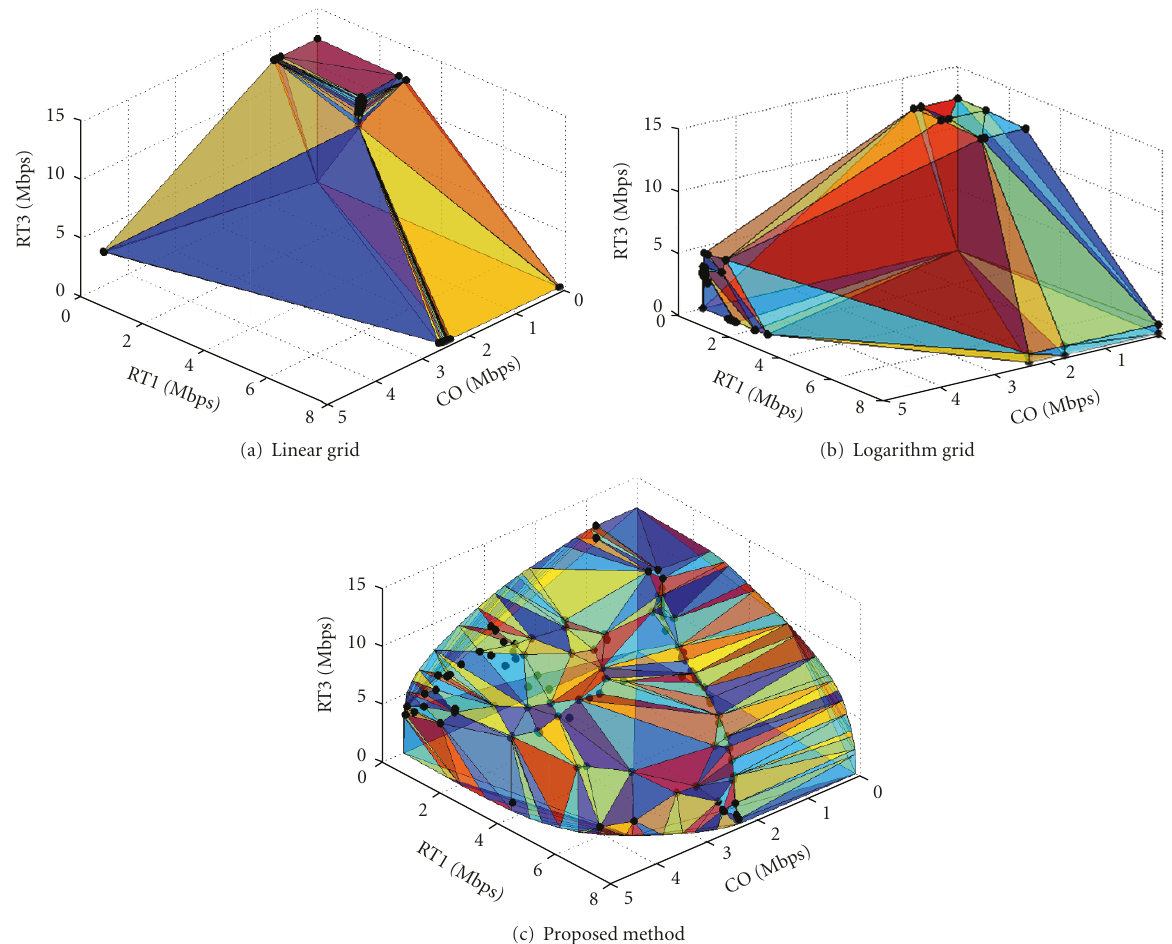
Figure 8: Results for the three-user case: (a) linear grid, (b) logarithm grid and (c) proposed diverseSB . All three methods used 1,000 SB runs and provided Z = 100 points. The shaping points are used for better visualization. Note that, in the 3D case, the performance of the logarithm grid was relatively worse than its performance in the 2D